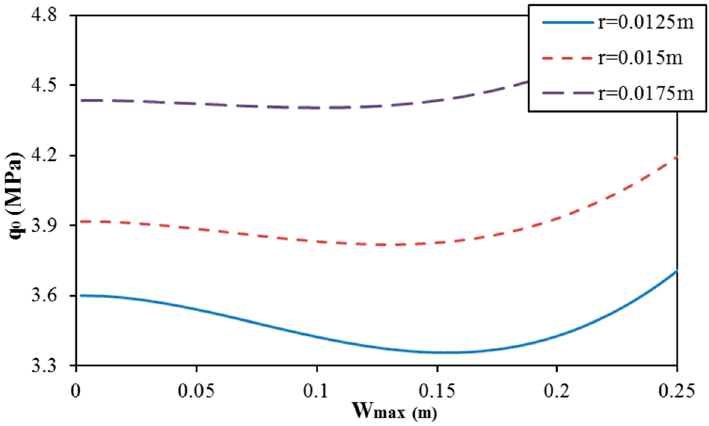
Figure 3. Effect of the number of waves of corrugation in a loop coil on the postbuckling curve of round spiral corrugated sandwich FGM cylindrical shells ( 1 K = 10 7 N/m 3 ; 2 K = 5 × 10 4 N/m, d = 0, r = 0.015 m, and k = 1).